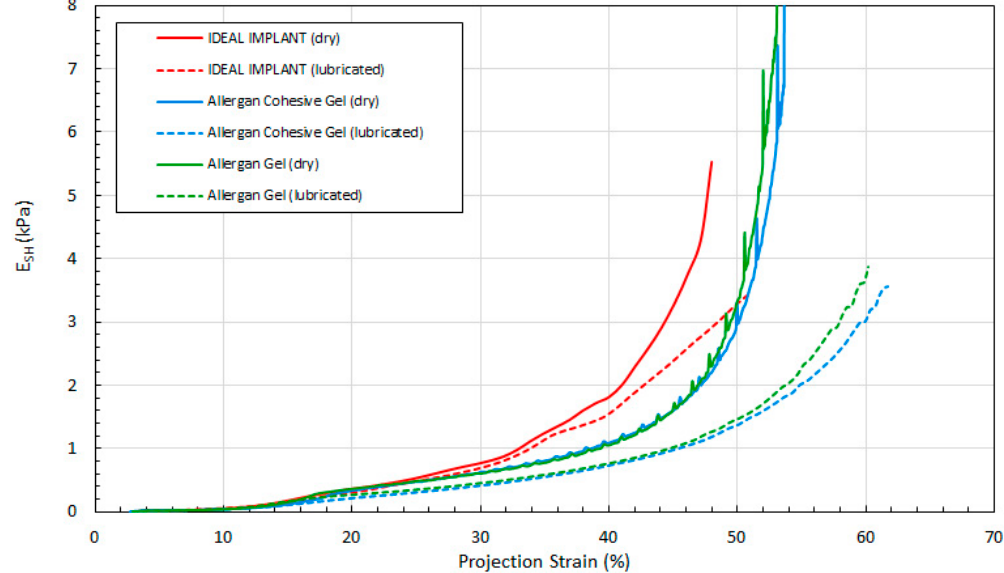
Figure 14. Projection Tangent Modulus with Projection Strain, Dry and Lubricated Platens.